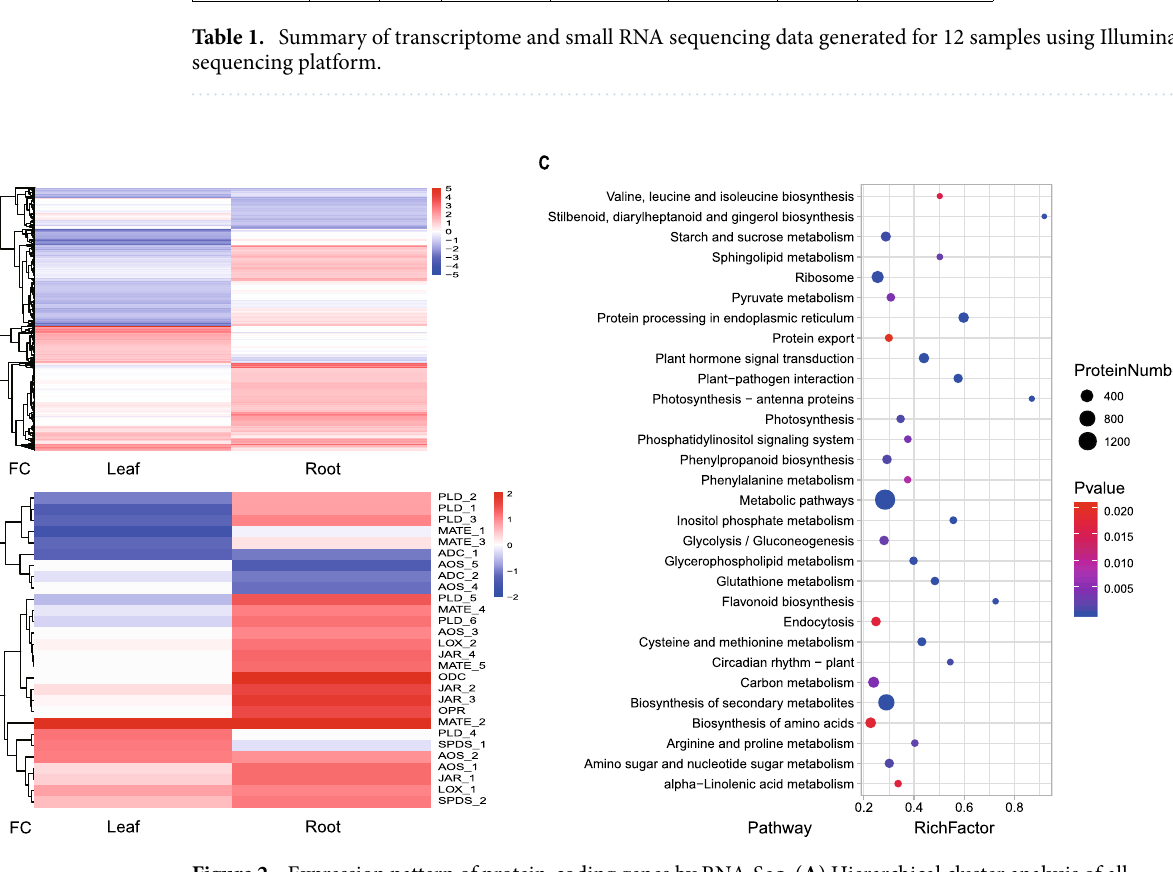
Figure 2. Expression pattern of protein-coding genes by RNA-Seq. ( A ) Hierarchical cluster analysis of all DEGs in leaf and root. ( B ) Hierarchical cluster analysis of known DEGs involved in nicotine biosynthesis. ( C ) KEGG pathway enrichment analysis for all DEGs. FC fold change, X-axis represents fold change between two